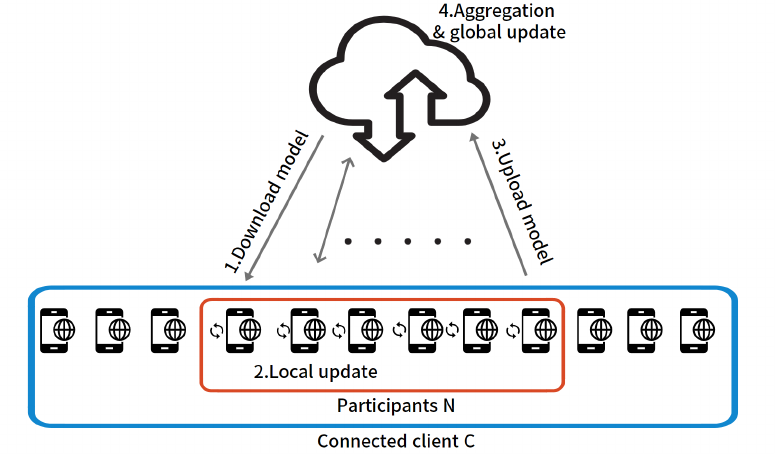
Figure 1. FL system